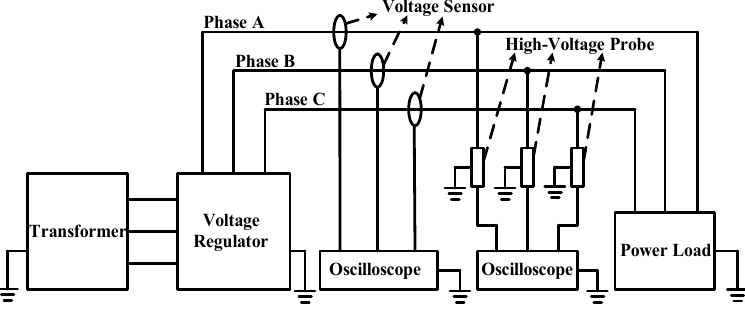
Figure 20. Schematic diagram for the structure of linearity test platform.